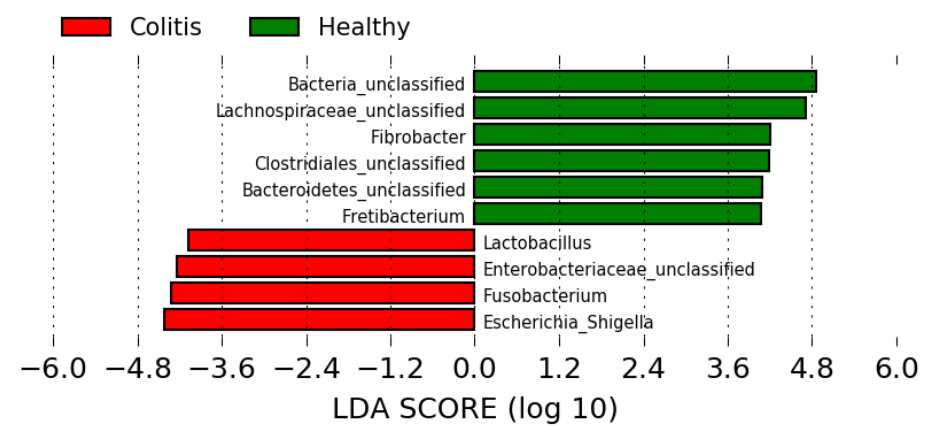
Figure 4. LEfSe analysis representing bacterial taxa statistically associated (LDA score > 4) with samples obtained from healthy horses (green) or horses with colitis (red).